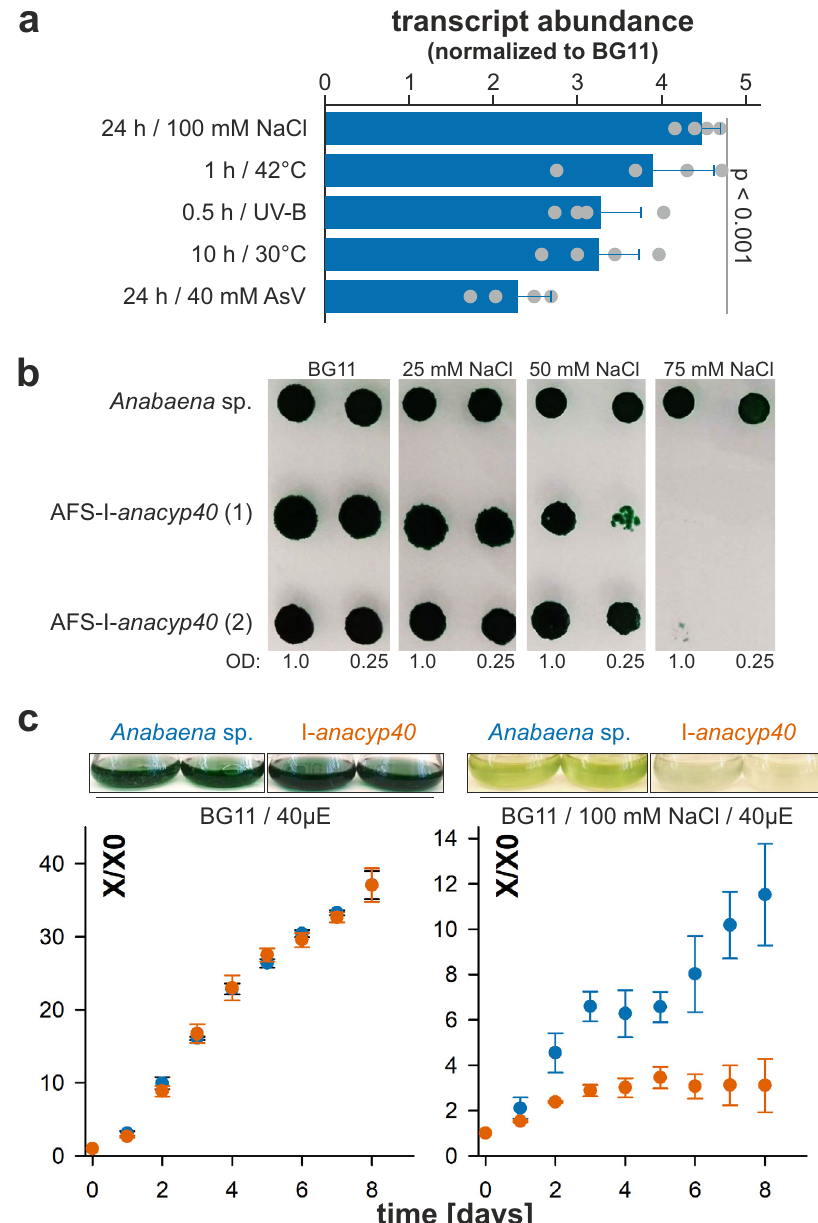
Fig. 2 ana Cyp40 is required for salinity stress response. a Wild-type Anabaena sp. was grown in BG11 and cells were treated as indicated followed by RNA isolation and qRT-PCR analysis with speci fi c oligonucleotides for anaCyp40 (Supplementary Table 4). The mean of the ratio to the mRNA abundance in non-treated cultures is shown and error bars indicate the standard deviation ( n = 4). The statistical signi fi cance determined by ANOVA (Duncans) of the difference to non-treated cultures is indicated. b Two independently generated AFS-I-a naCyp40 strains and wild-type cells were spotted at two indicated concentrations at BG11 supplemented with indicated concentrations of NaCl. The plates were imaged after 8 days of growth. c Wild-type (blue) and AFS-I-a naCyp40 (orange) were grown in BG11 liquid medium (left) with additional 100 mM NaCl (right). The culture density was imaged after 8 days (top) and the average values and the standard deviation for the growth of three independent cultures normalized to the OD at the start of the analysis are shown (bottom). Source data are provided as a Source data fi